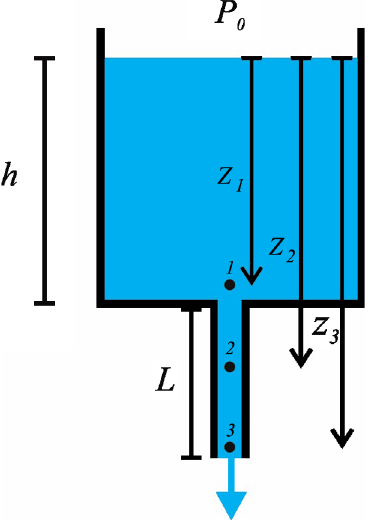
FIG. 7. Open container with a vertical draining pipe. Three points, 1, 2, and 3 at different heights z 1 , z 2 , and z 3 , are